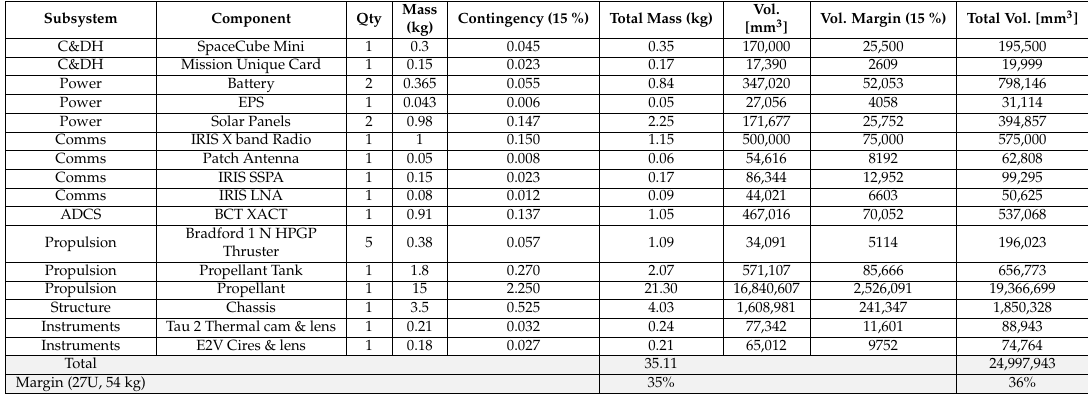
Table 3. Mass and volume budgets of the Perseus